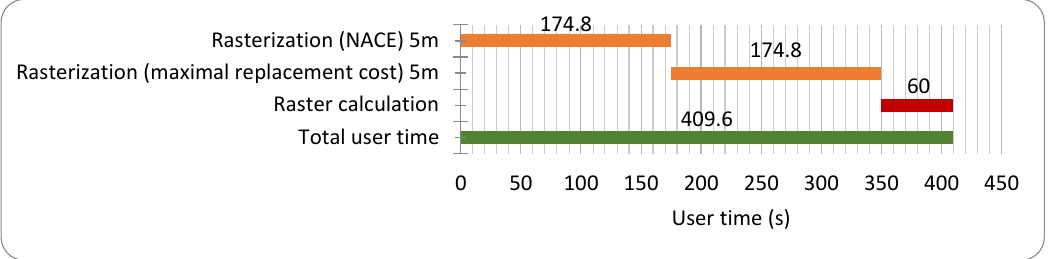
Figure 21. User time to calculate the economic impact for a road network in Ghent resulting from a fluvial flood event (return period 1000 years) with a raster approach (5 m resolution).